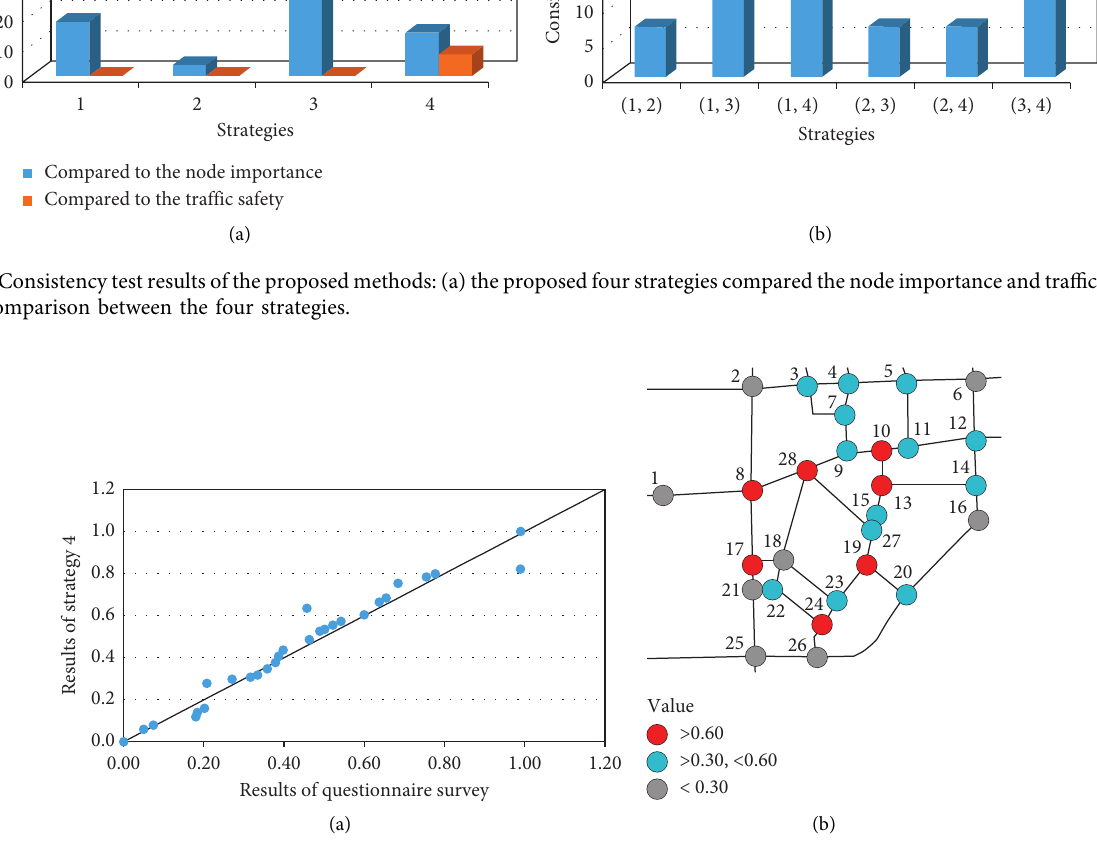
Figure 5: Comparison between the results of questionnaire survey and the proposed framework with strategy 4: (a) compared to the questionnaire survey and (b) differences with ranking